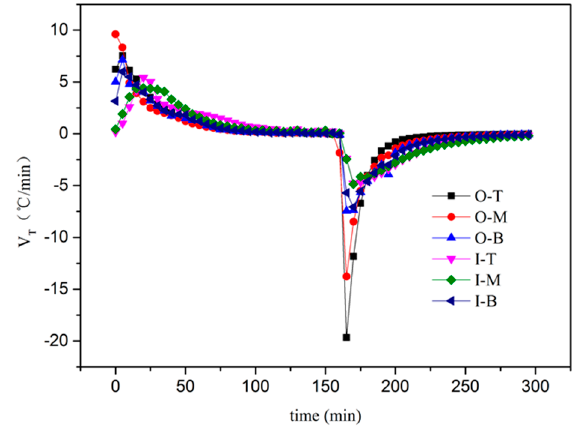
Figure 4. Temperature rate of the adsorbent bed.